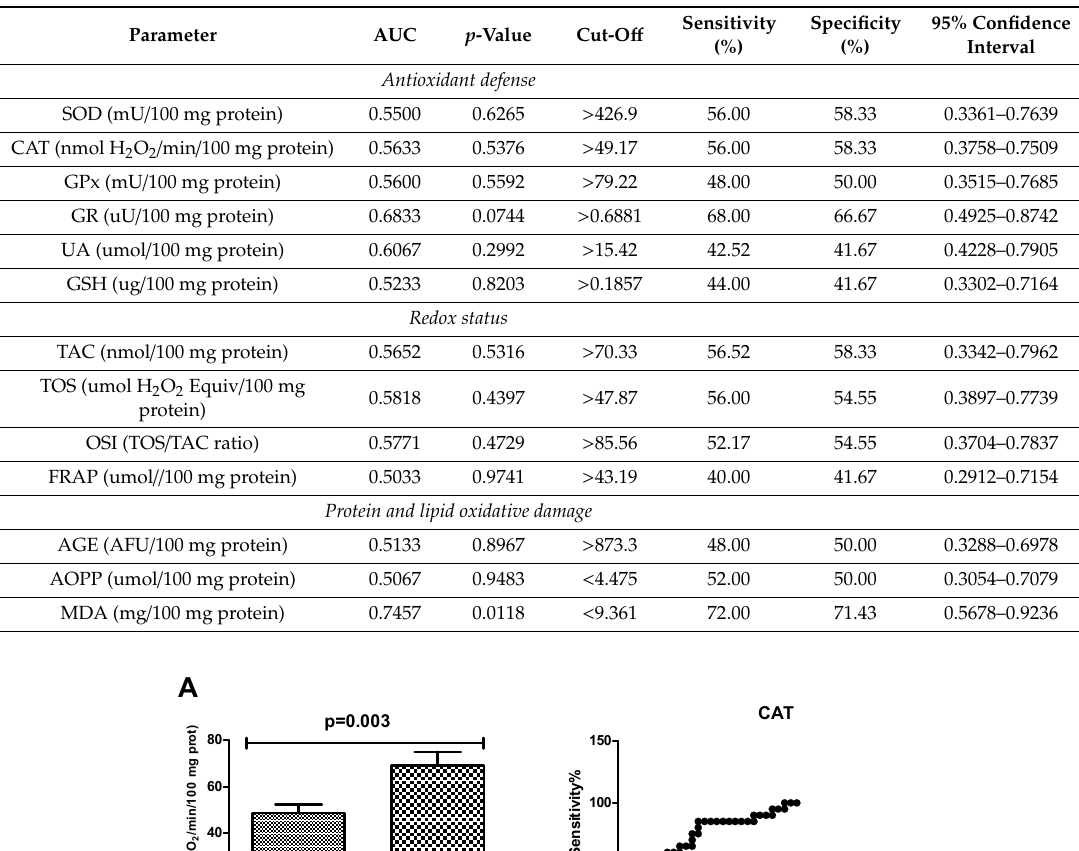
Table 4. Receiver operating characteristic (ROC) analysis of oxidative stress biomarkers of colorectal cancer patients with the tumour grown into the muscularis propria (pT2) and with the tumour grown through the muscularis propria and into the subserosa (pT3). Abbreviations: SOD, superoxide dismutase-1; CAT, catalase; GPx, glutathione peroxidase; GR, glutathione reductase; UA, uric acid; GSH, reduced glutathione; TAC, total antioxidant capacity; TOS, total oxidant status; OSI, oxidative stress index; FRAP, ferric reducing ability of sample; AGE, advanced glycation end products; AOPP, advanced oxidation protein products; MDA, malondialdehyde.